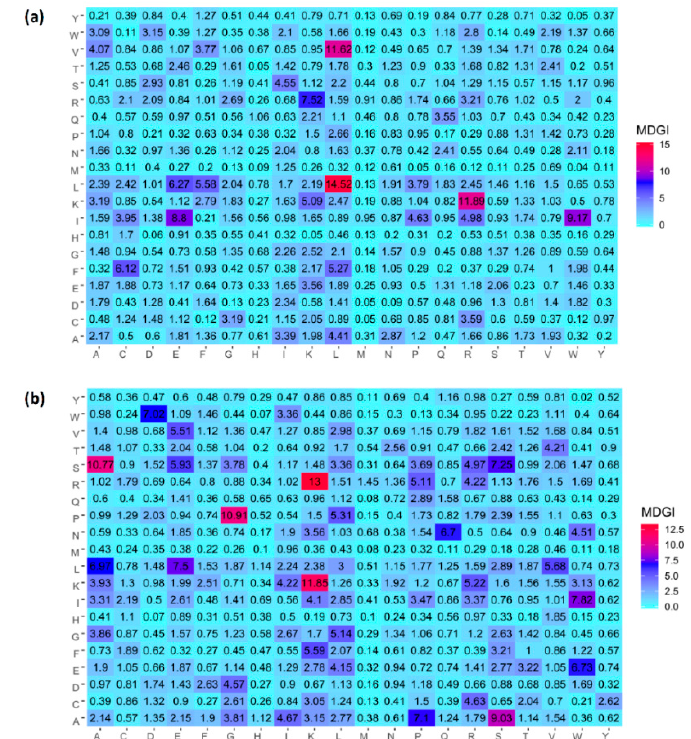
Figure 3. Heat map of the mean decrease of Gini index of dipeptide compositions for the T 544p + 407n + V 60p + 45n ( a ) and T 544p + 544n + V 60p + 60n ( b ) datasets. It should be noted that features with the largest value of MDGI are deemed to be the most important.